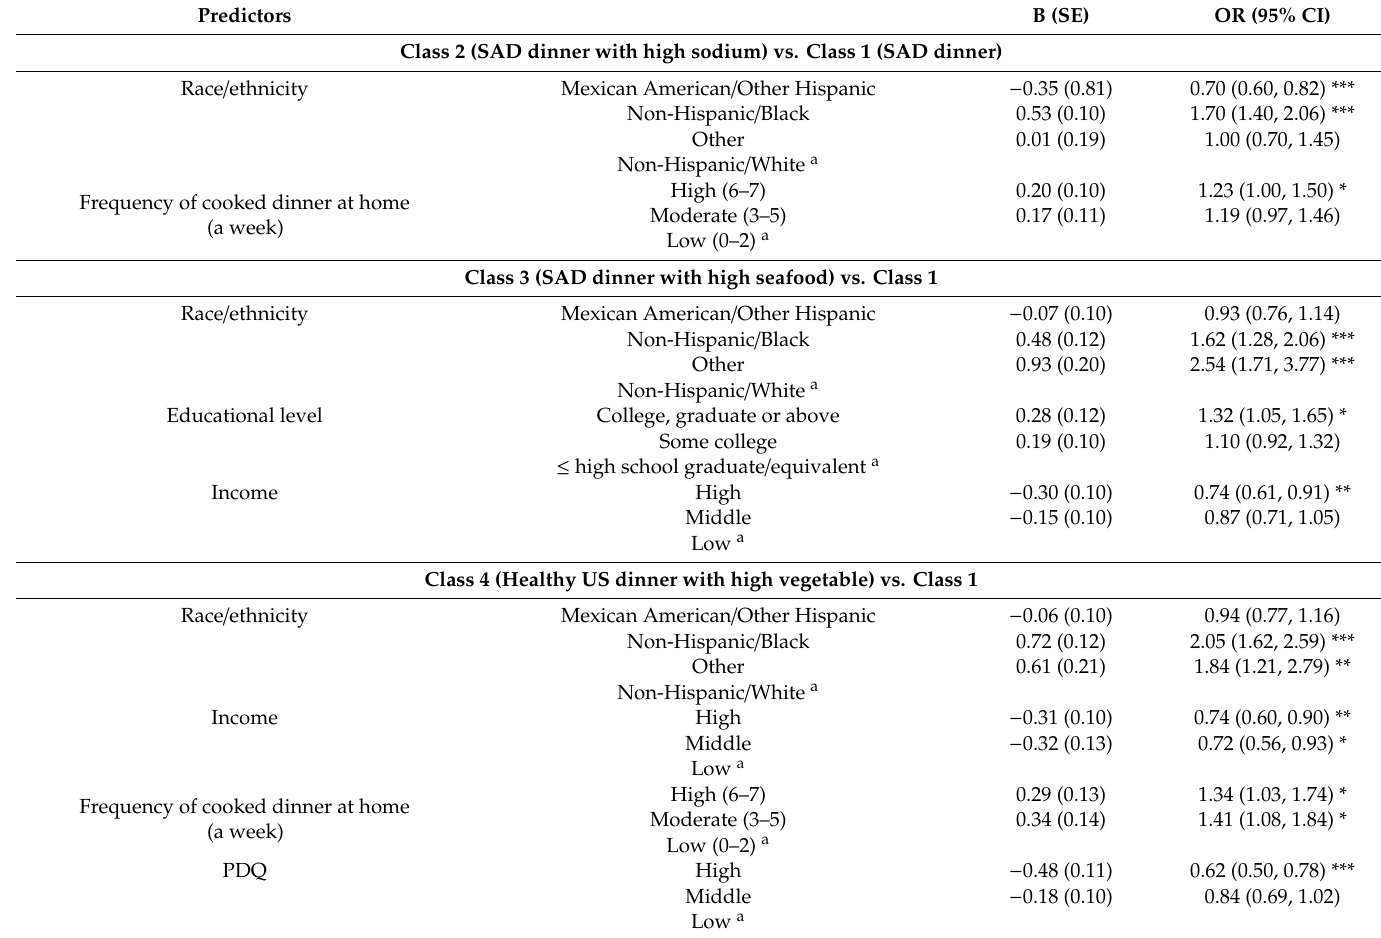
Table 8. Predicting dinner dietary patterns (latent classes): multinomial logistic regression of the NHANES 2007–2010 population (age ≥ 19 years, N =